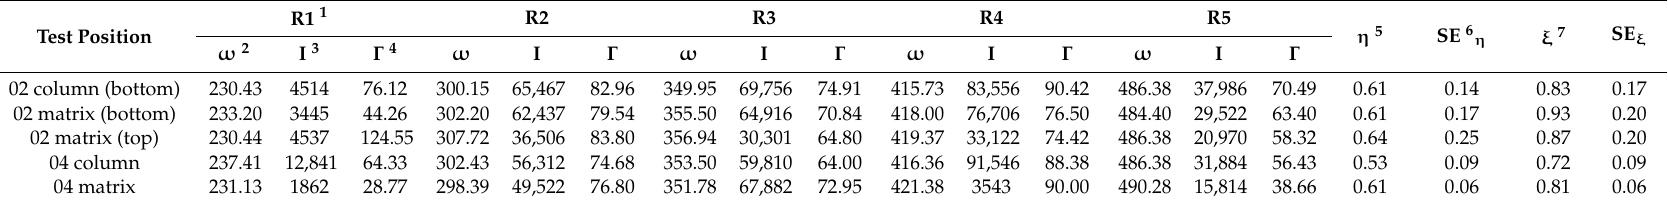
Table 2. Band parameters after fitting the Raman